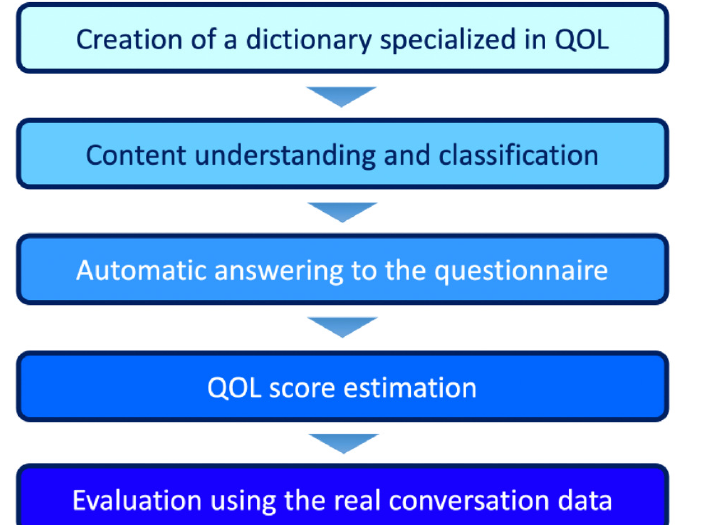
Figure 1. Flowchart of overall frame design.